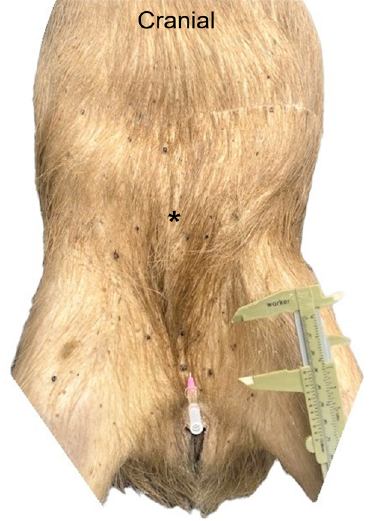
Figure 3. Capybara in dorsal recumbency for ventral abdominal dissection. The dissection started 1 cm cranial to the pubis (pink catheter) until the umbilical scar (asterisk). The incision was extended cranially for description of the abdominal viscera anatomy and syntopy.